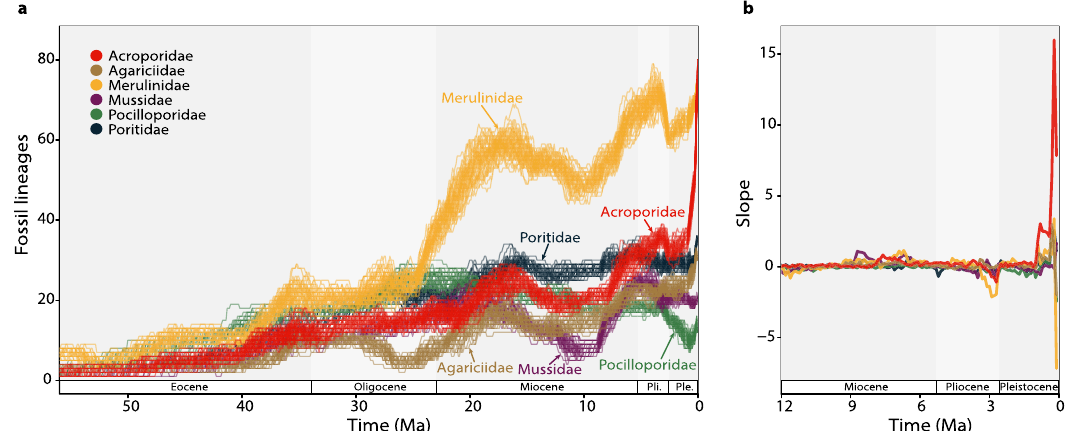
− Fig. 2 Fossil lineages through time in six extant reef coral families. a Reconstruction of fossil diversity trajectories estimated through a time-variable Poisson process of preservation. Models were run independently in each family and were replicated fi fty times (individual lines) to incorporate uncertainty around the age of the fossil occurrences. b Mean rate of diversity change (slope in species per 0.1 Myr) in the last twelve million years for the same coral families, calculated as the difference in diversity between subsequent time points (see Methods). Acroporidae — red; Agariciidae — brown; Merulinidae — yellow; Mussidae — purple; Pocilloporidae — green; Poritidae — dark blue. Source data are provided as a Source Data fi le. NATURE COMMUNICATIONS| (2022) 13:2426 |https://doi.org/10.1038/s41467-022-30234-6|www.nature.com/naturecommunications